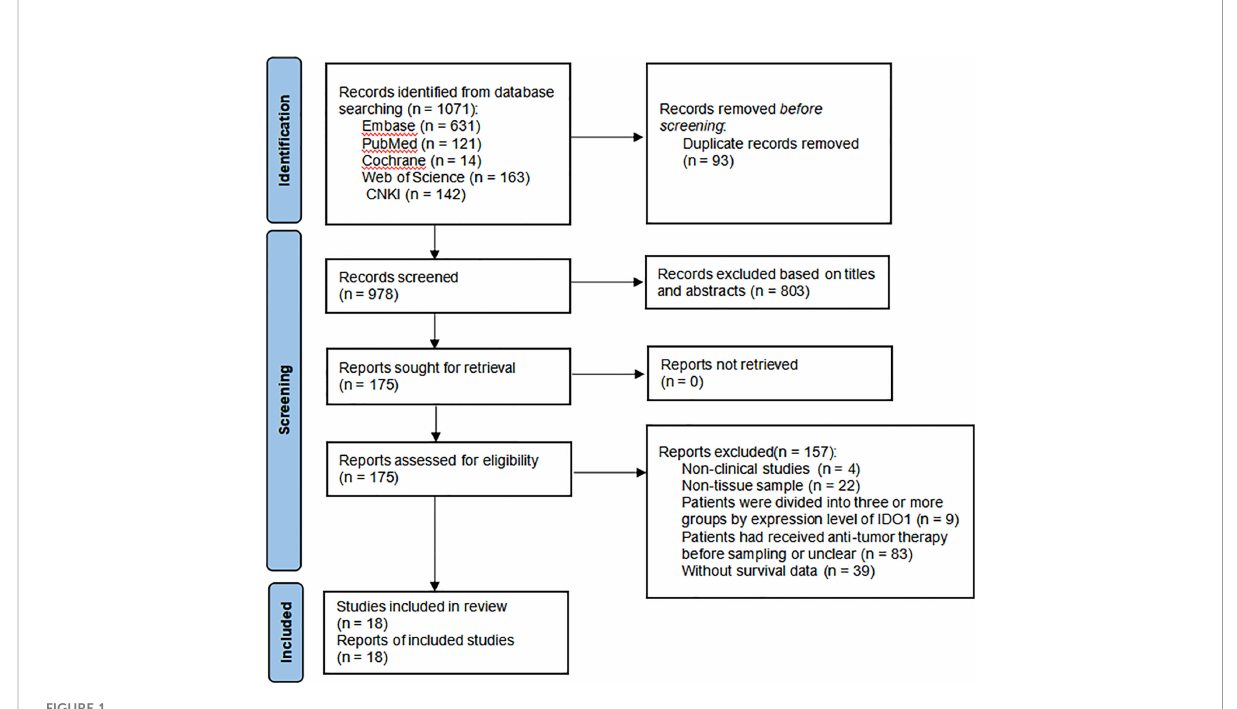
FIGURE 1 Flow diagram of the study